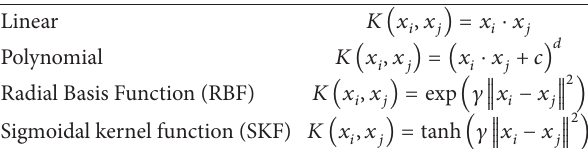
Table 2: The commonly used kernel